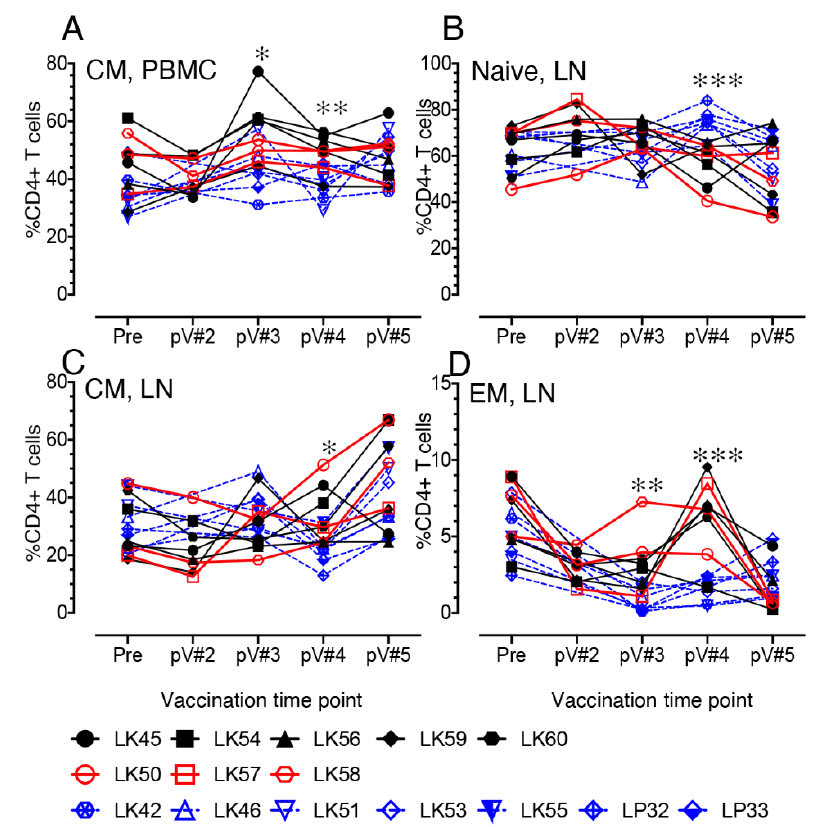
Figure 4. Dynamics of different T cell population during vaccination in vaccinated and control macaques in PBMC and lymph node tissues. Frequency of central memory (CM, A , C ), naïve ( B ), and effector memory (EM, D ) CD4 T cell population in PBMC and lymph node (LN) is shown for vaccine ( n = 8) and control ( n = 7) animals over the vaccination time points. Black and red lines represent vaccine infected (VI) and vaccine protected (VP) macaques, respectively. Blue dashed lines represent control macaques. Asterisks denote statistically significant differences between vaccine and control groups for the specific time point (* p < 0.05, ** p < 0.01, and *** p < 0.001).